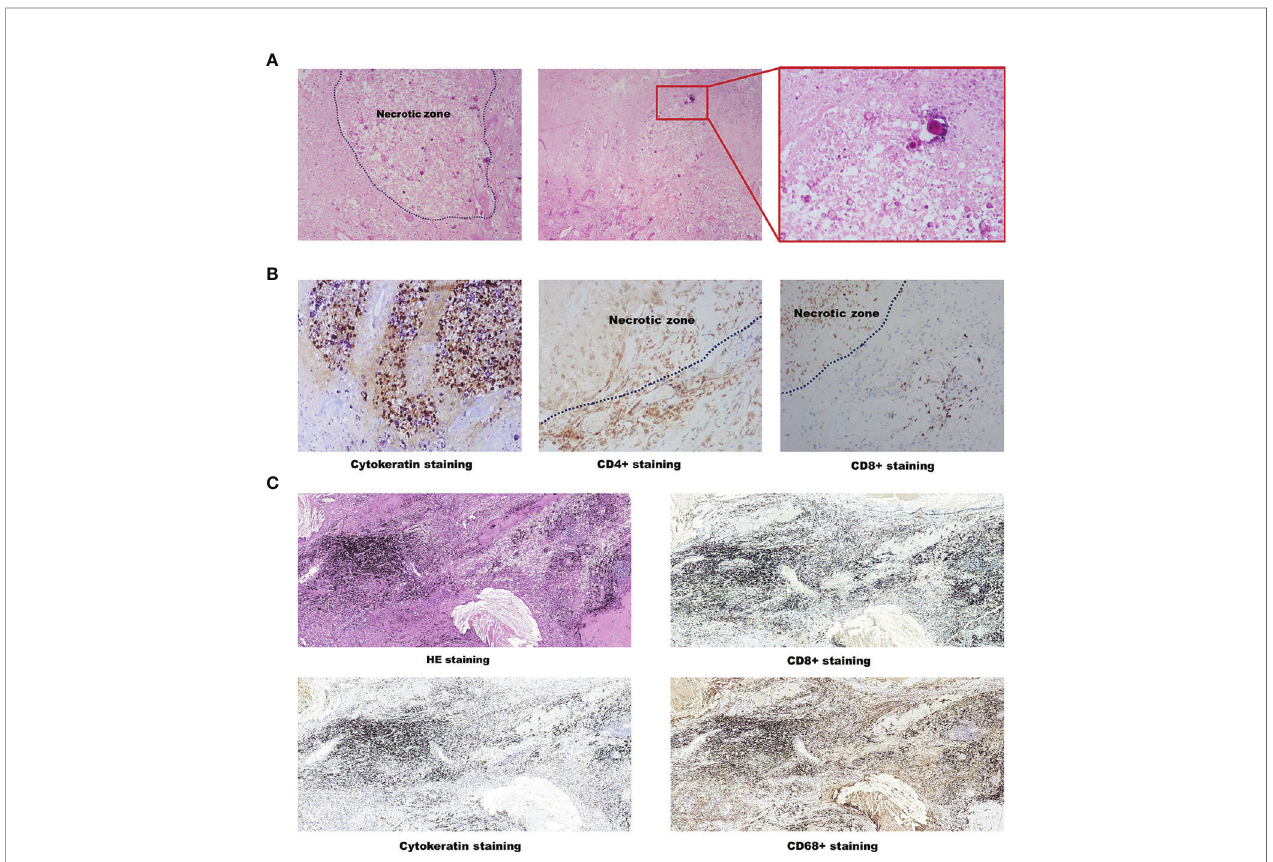
FIGURE 2 | Pathological results of postoperative specimens. (A) Hematoxylin-eosin staining of brain tumor tissue. (B) CK, CD4 + and CD8 + staining of brain tumor tissue. (C) HE, CD8+, Cytokeratin and CD68+ of lung tumor tissue. HE,